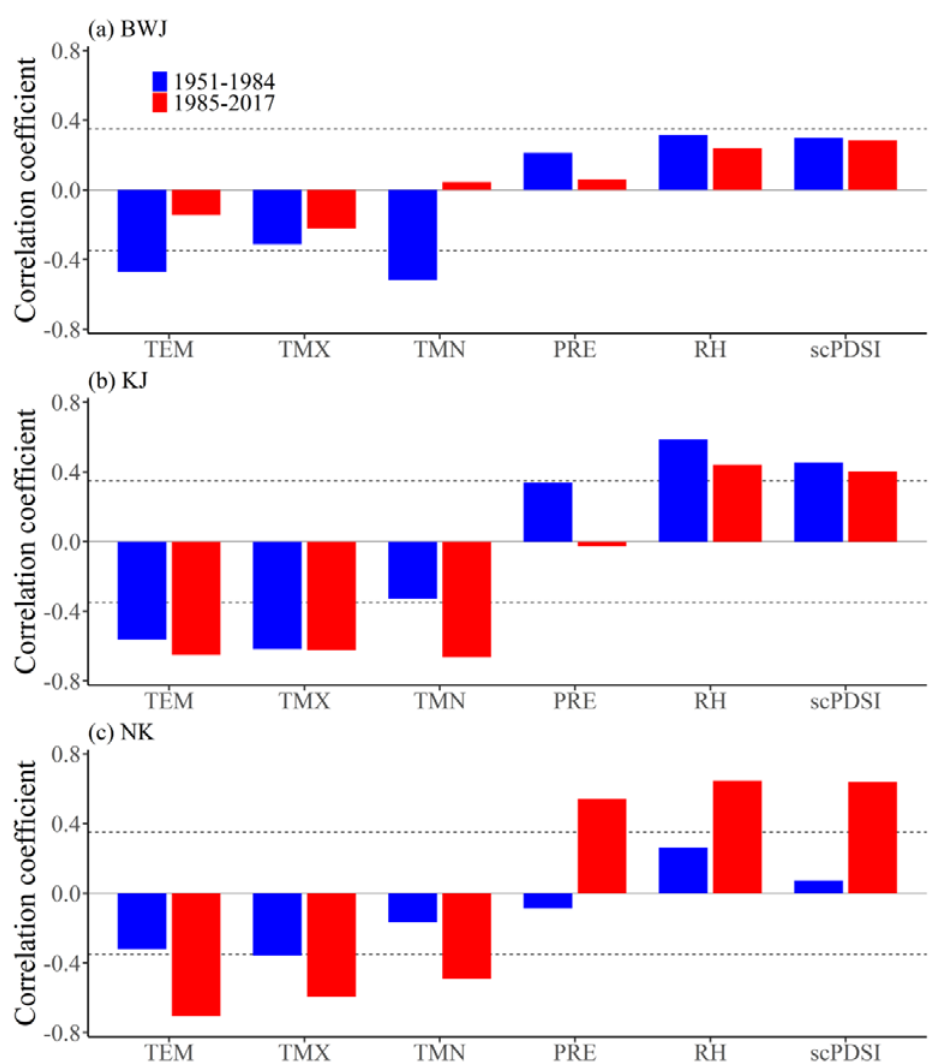
Figure 5. Correlation coefficients between tree-ring residual chronologies and climate factors for the transition season from April to June for the two sub periods of 1951–1984 and 1985–2017 at three sites (BWJ, KJ and NK) in Thailand. Climate factors include mean temperature (TEM), maximum temperature (TMX), minimum temperature (TMN), precipitation (PRE), relative humidity (RH) and self-calibrated Palmer drought severity index (scPDSI).